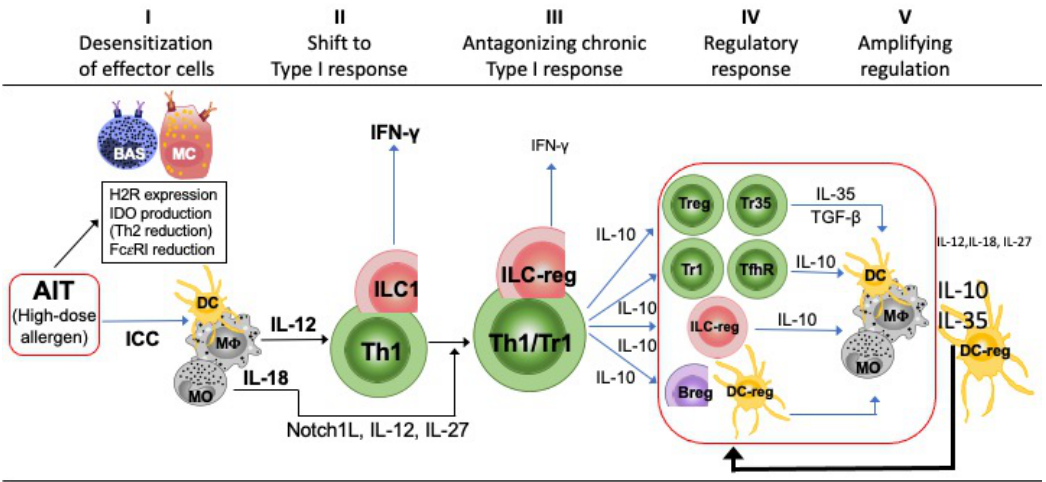
Figure 1. Timing schedule of alterations induced by AIT. Five sequential time phases can be hypoth- esized, named from I to V in the figure and described in the text.